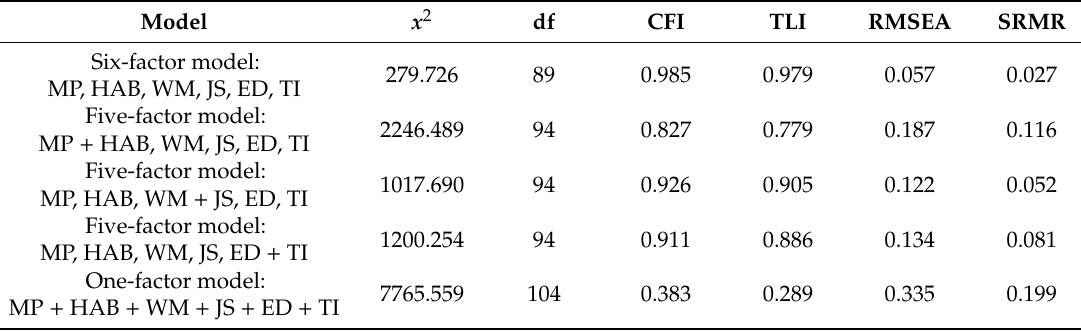
Table 2. Results of the confirmatory factor analysis.